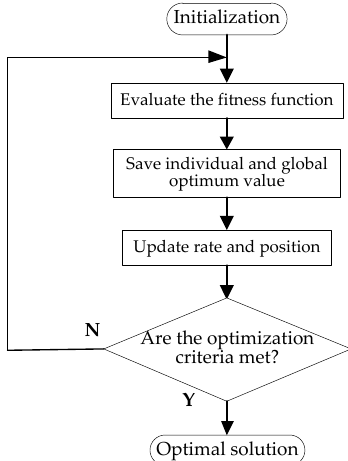
Figure 5. Basic structure of the particle swarm optimization (PSO) algorithm.